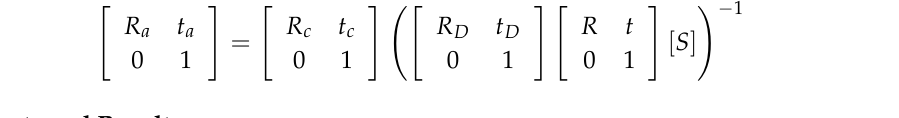
Table 1. Comparison of median (maximum) absolute trajectory error in mm for joint optimization on RGB-D sequences of the Freiburg Benchmark Dataset, Best results in bold. Datasets